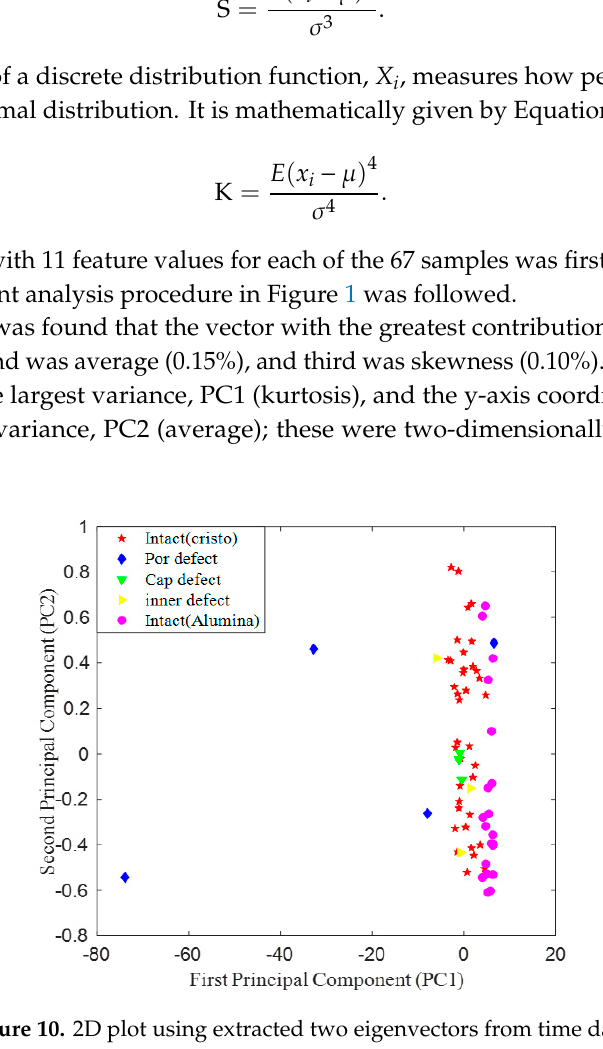
Figure 10. 2D plot using extracted two eigenvectors from time data.